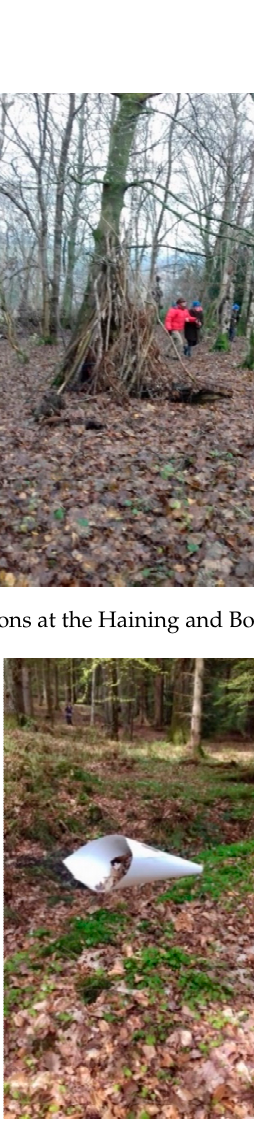
Figure 2. Extending Practice Sessions at the Haining and Bowhill Woods. Image, author’s own.